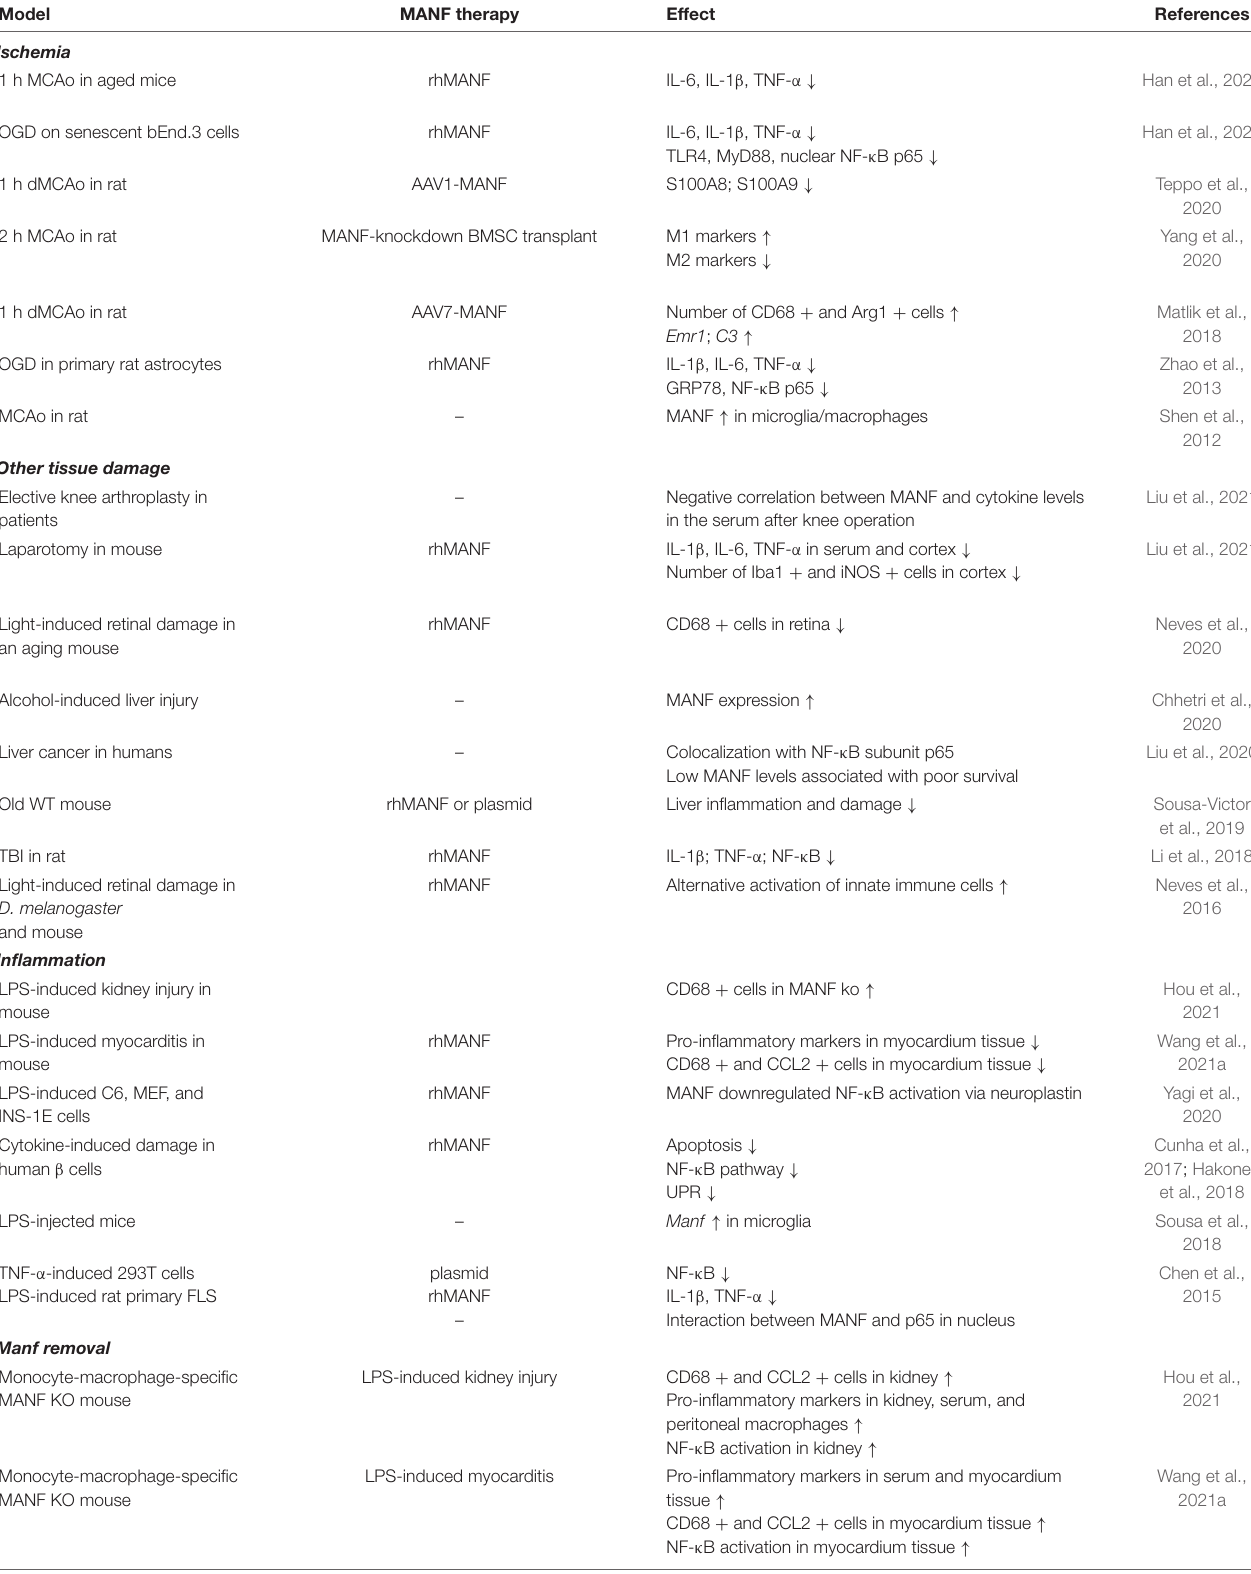
TABLE 3 | Immunomodulatory effects of